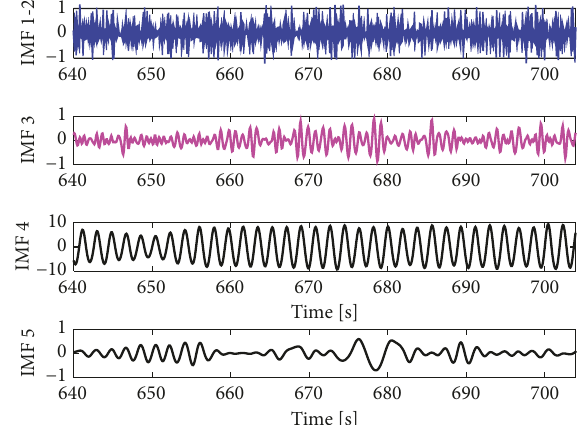
Figure 26: A plot of the first 5 IMFs extracted from the analyzed segment of the studied Ringhals